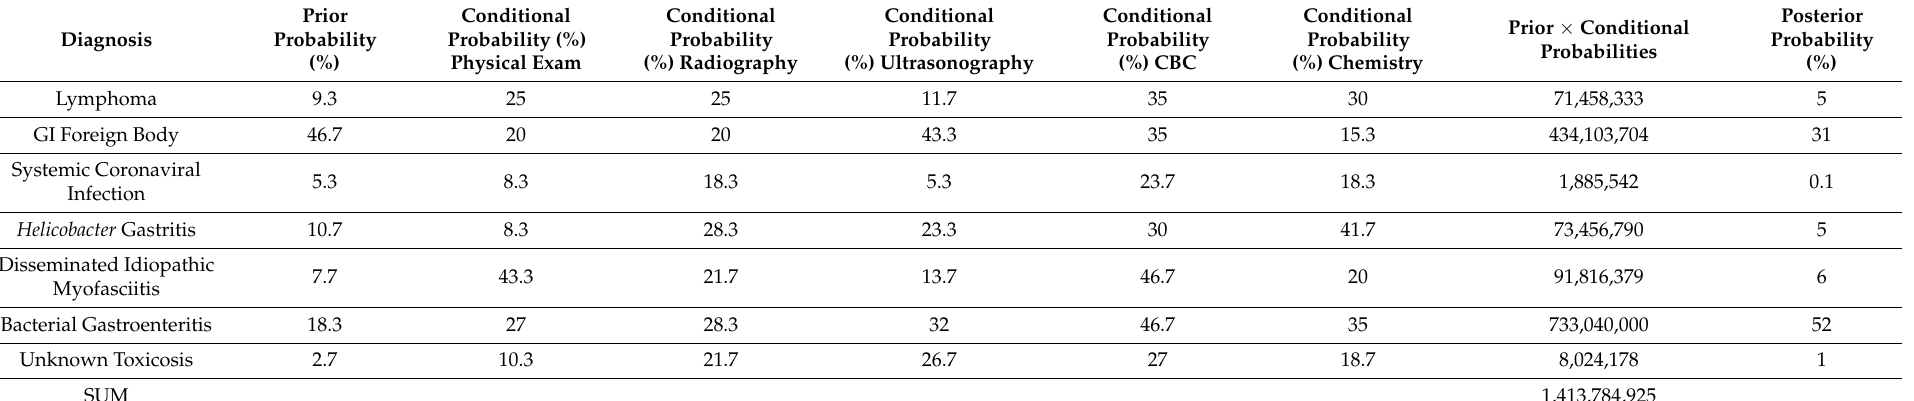
Table 1. Outside clinician-derived composite prior and conditional probabilities for differential diagnoses and diagnostic findings, respectively, in an approximately 1-year-old ferret presenting for two days of lethargy and inappetence, and one day history of diarrhea. Pre-surgical posterior probabilities are also shown.